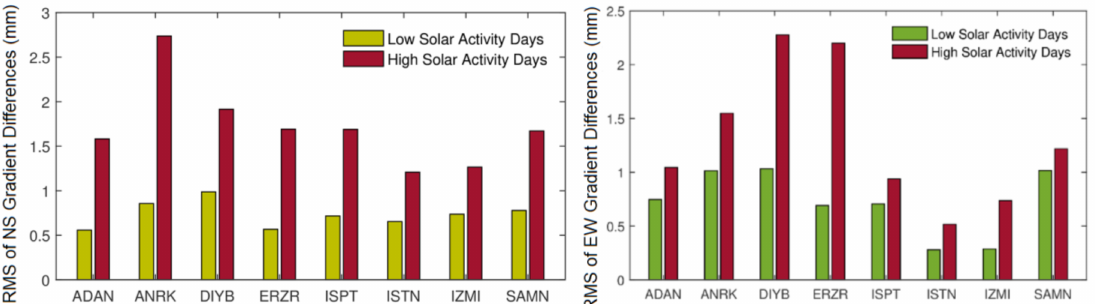
Figure 8. RMS of NS ( left ) and EW ( right ) gradient di ff erences during low (days 18–24) and high (days 317–323) solar activity